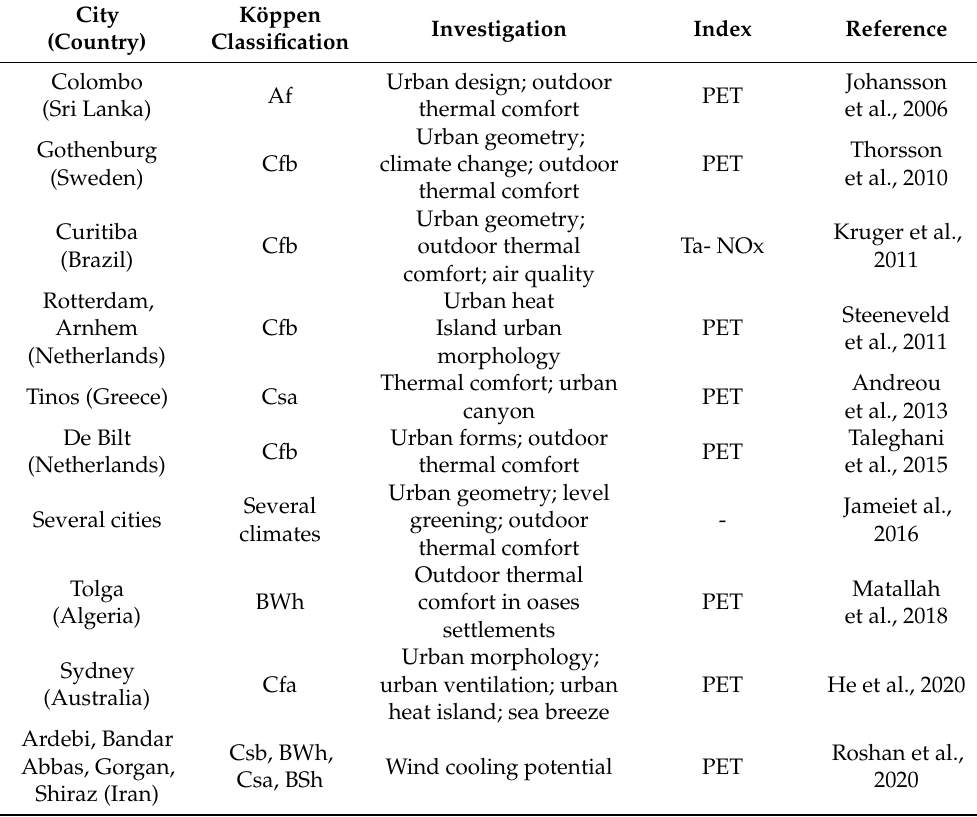
Table A1. Studies on outdoor thermal comfort and corresponding modern cities.